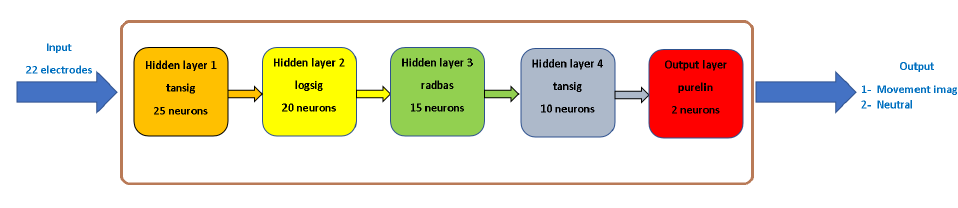
Figure 17. Structure of the designed neural